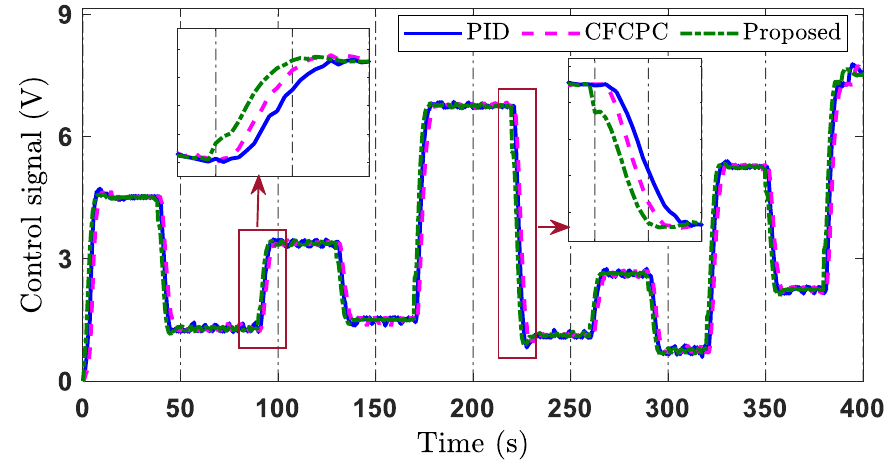
Figure 12. Voltage control signal in the experiment.